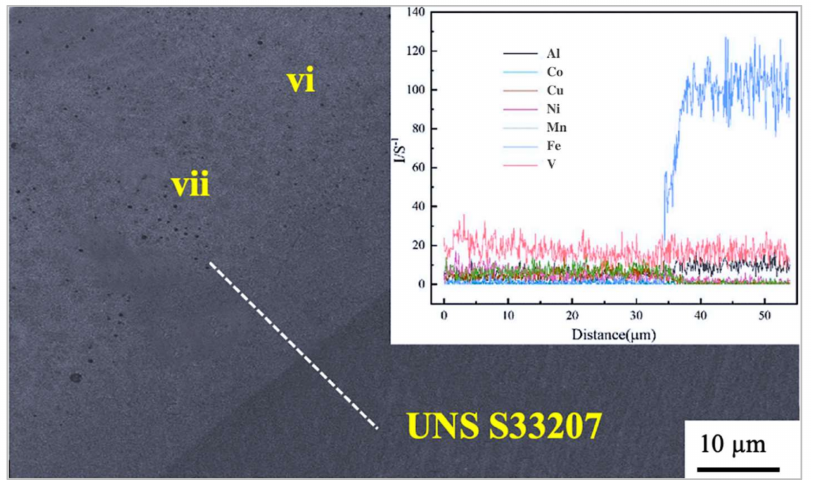
Figure 7. Weld interface SEM image (from area D in Figure 2). vi and vii are the areas where EDS